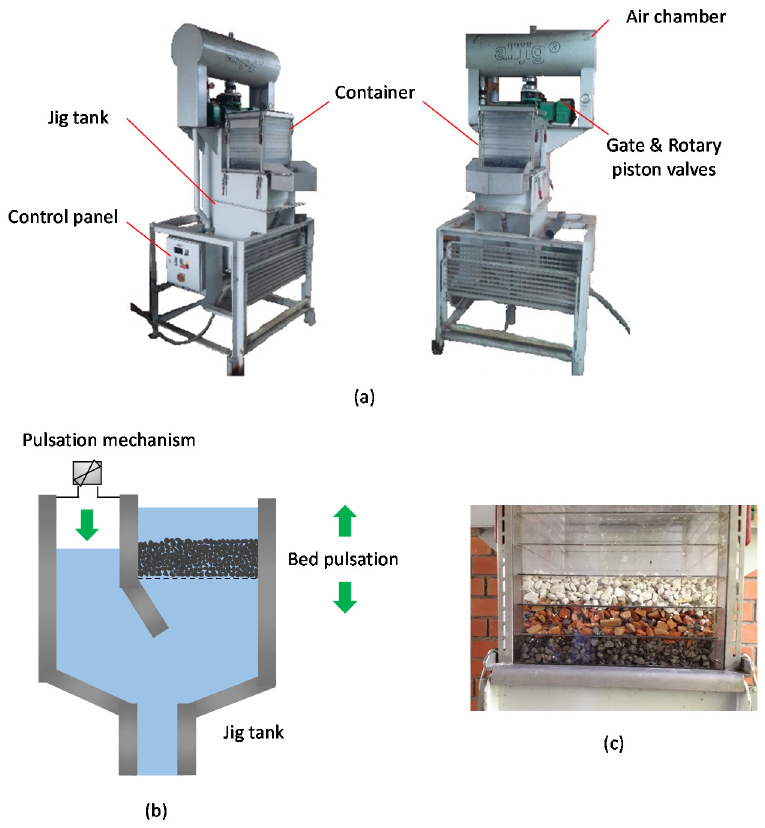
Figure 2. Jigging equipment scheme ( a ); Baum jig operation principle ( b ); Merely illustrative picture of jig container filled with aggregates ( c ).